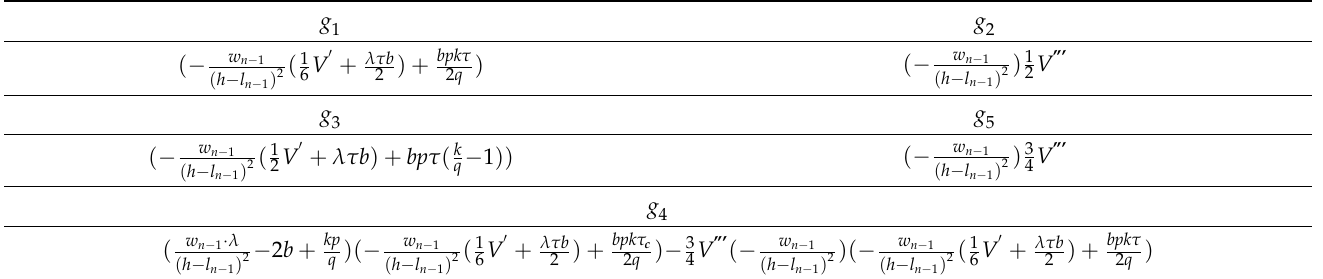
Table 1. The coefficients g i in Equation